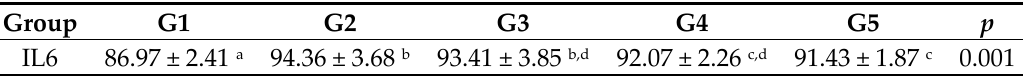
Table 1. IL6 expression of groups.